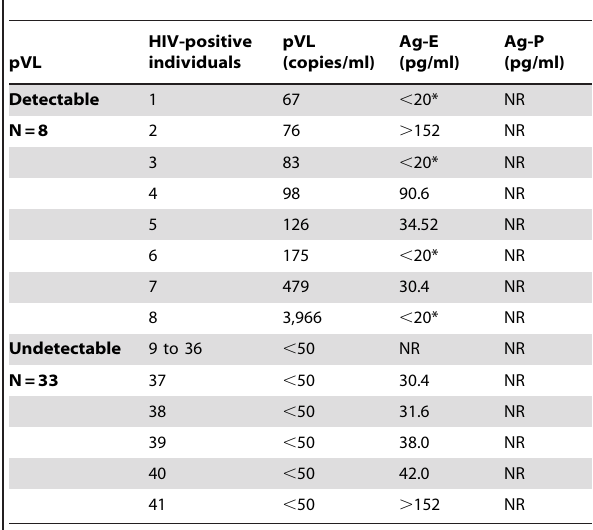
Table 2. p24-antigen associated to erythrocytes in individuals with consecutive undetectable plasma viral load for one